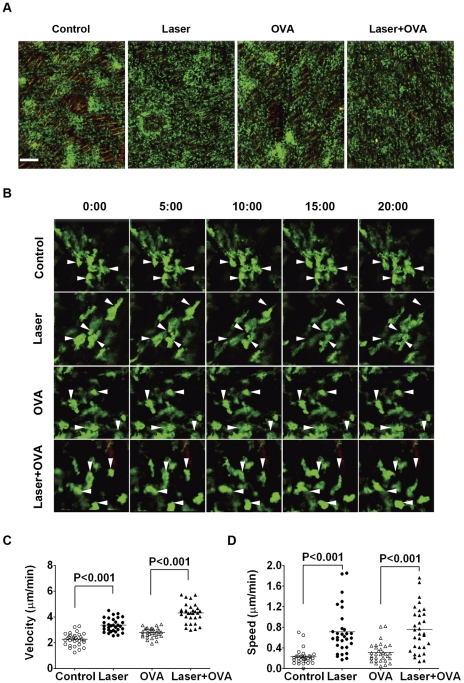
Laser increases the mobility of dermal APCs.
A. Altered distribution of dermal APCs after laser illumination. Distribution of dermal APCs in MHC-II EGFP transgenic mice was analyzed by intravital confocal microscopy after 5 hrs of laser illumination for 2 min at 0.3 W with or without OVA administration. Scale bar: 200 µm. B. Increased motility of individual cells after laser illumination. Representative time-lapse images demonstrated migratory behaviors of dermal APCs within a 20 minute period of recording: arrows indicate the original location of the cell. C and D. Quantification of cell motility affected by laser illumination. Mean mobile velocity (C) or migratory speed (D) of randomly selected pseudopods was imaged in 5 hrs after laser illumination and OVA injection and analyzed by Image J software. Each symbol represents data of a single pseudopod. n = 31.